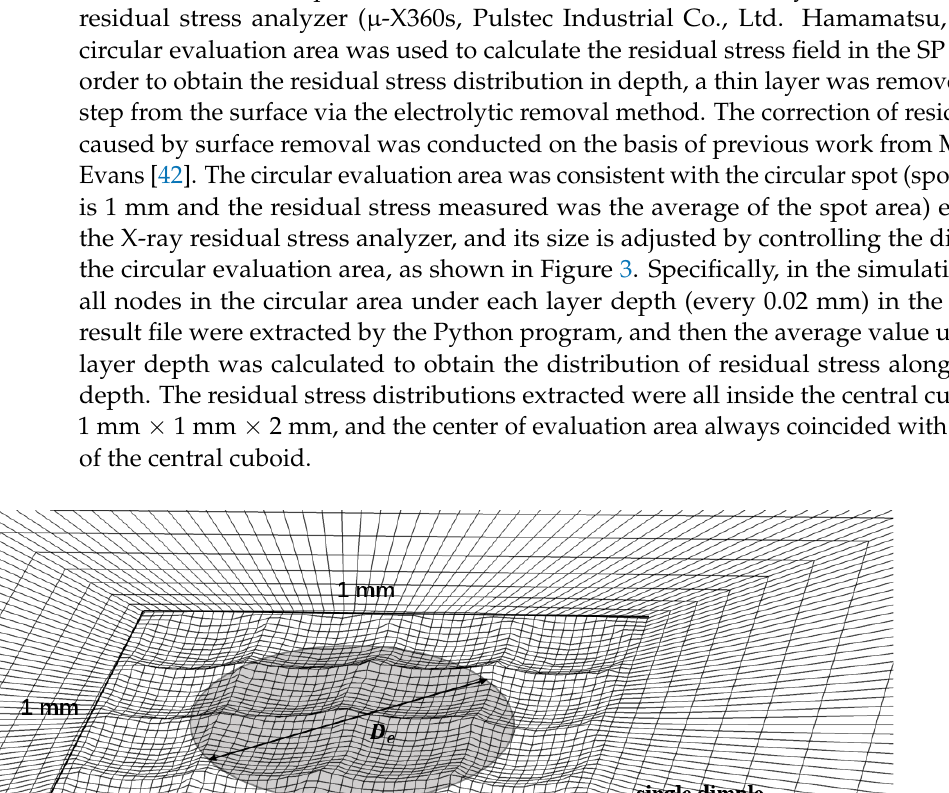
Figure 3. The schematic diagram of residual stress evaluation area.